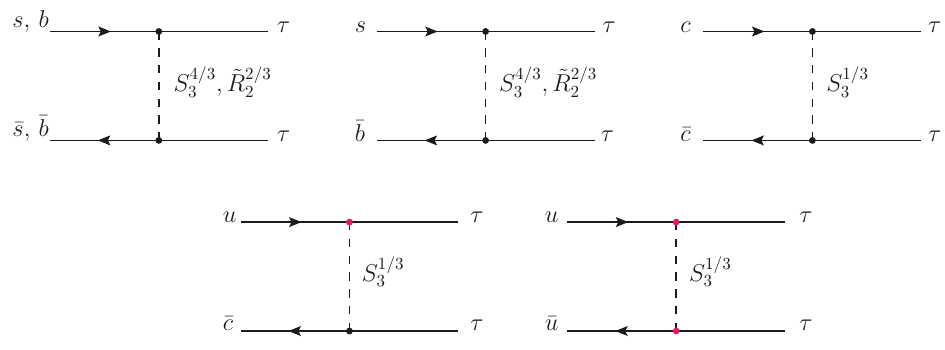
~ R ! (cid:28) + (cid:28) (cid:0) 3 and 2 exchanges in pp